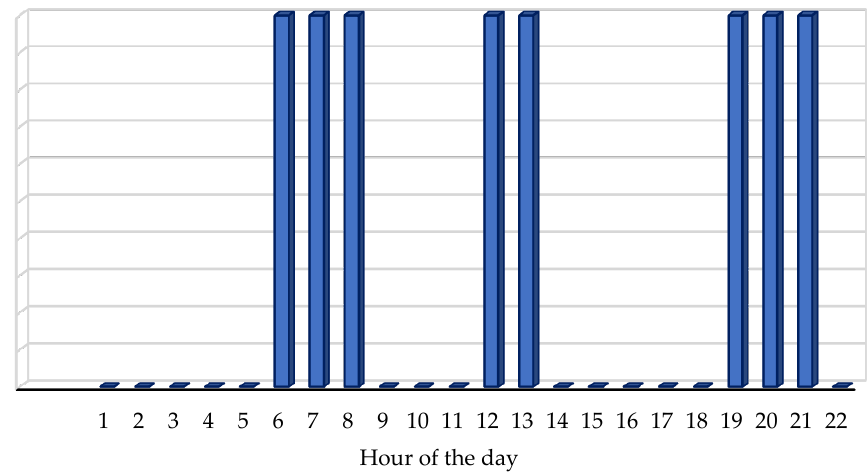
Figure 14. Split system operation schedule used for CASE 4, 6 and 8.